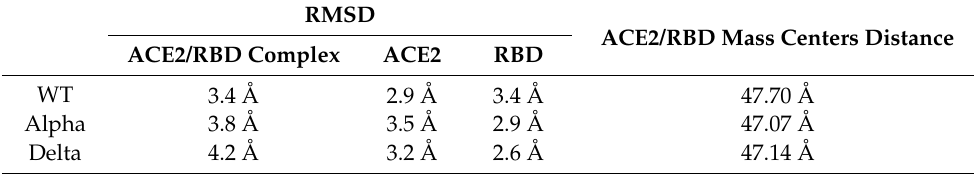
Table 1. Average RMSD values and distance between the mass centers of ACE2 and